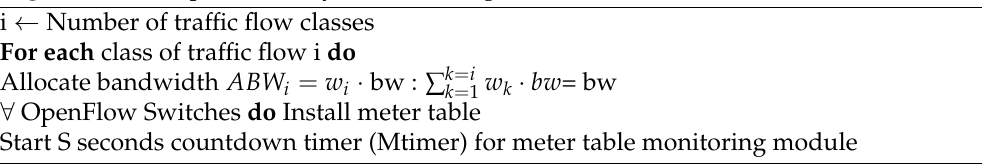
Algorithm 1 Adaptive Quality of Service Algorithm: Initialization Phase